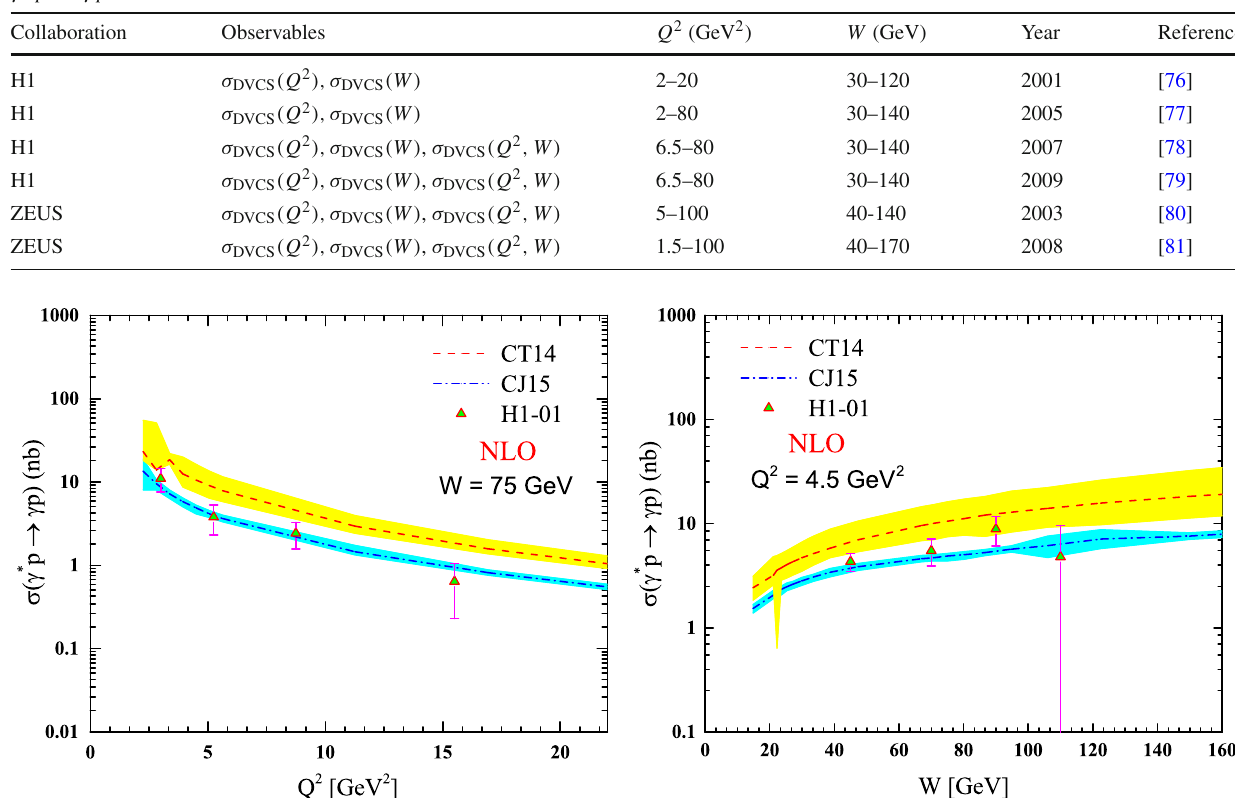
results based on the input of Eq. (1) and CT14 [67] and CJ15 [68] PDFs. The shadowed bands represent the uncertainty of the corresponding PDFs